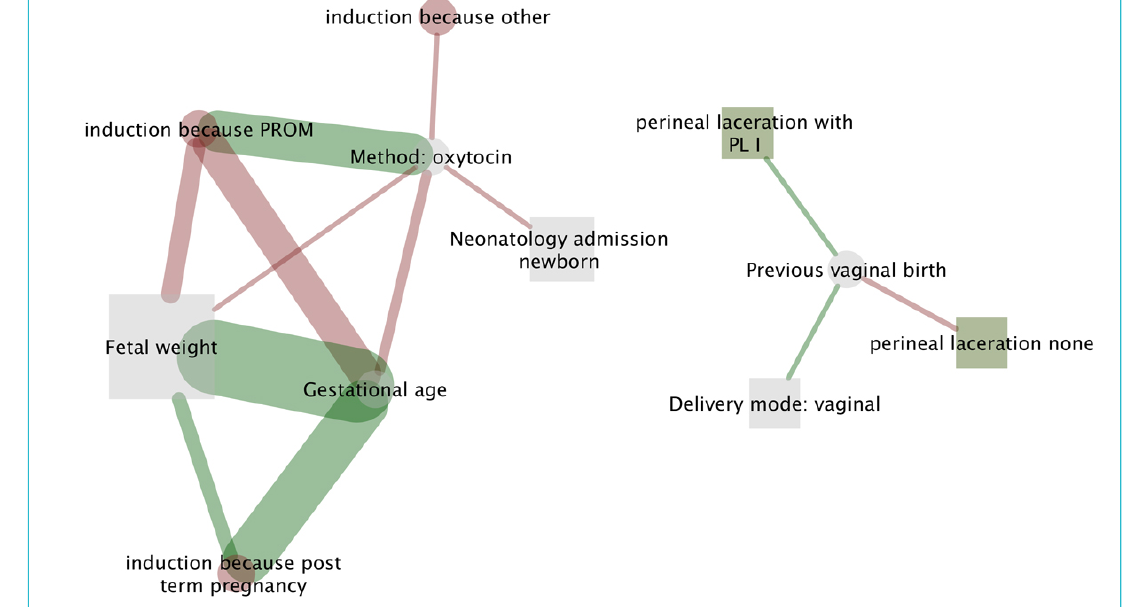
Figure 1: All significant one-to-one correlations in the cohorts (induction method catheter and oxytocin after caesarean section; for details see table 2). Each edge represents a statistically significant relationship between two variables. Positive correlations are indicated by the colour green (for example the gestational age correlates positively with the fetal weight: the more advanced the gestational age, the higher the fetal weight). Negative correlations are indicated by the colour red (for example, labour induction because of PROM is correlated to a lower birth weight). Predictive variables (factors) are indicated with circles and outcome variables with squares (for example induction because post- term pregnancy is a predictive factor for higher fetal weight). The size of the squares reflects the overall